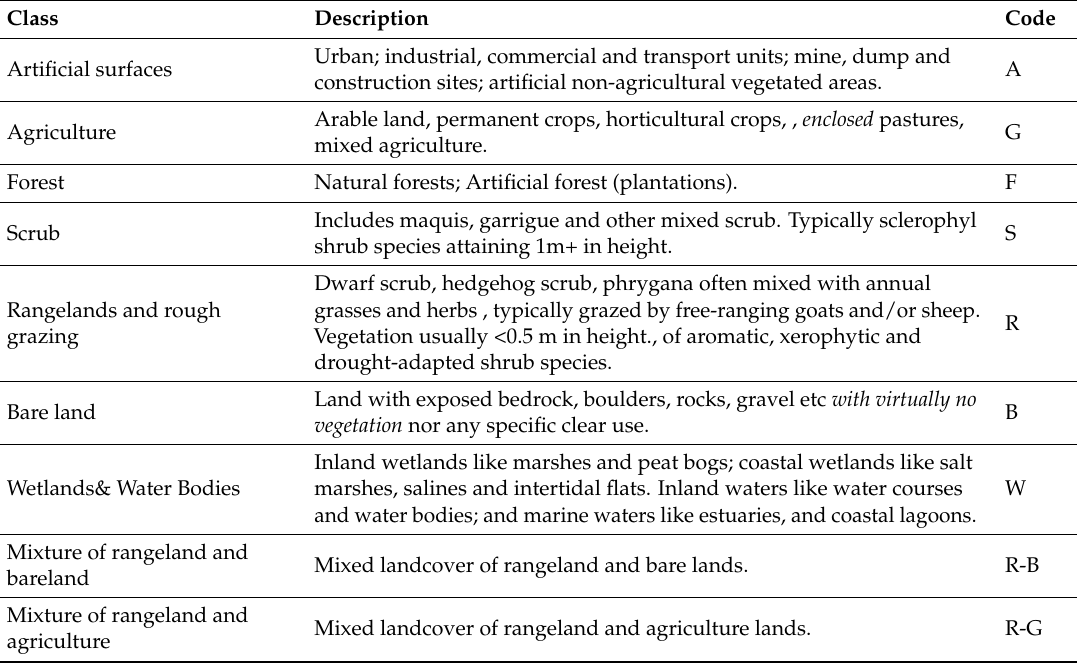
Table 3. Land cover, description, and the code of each